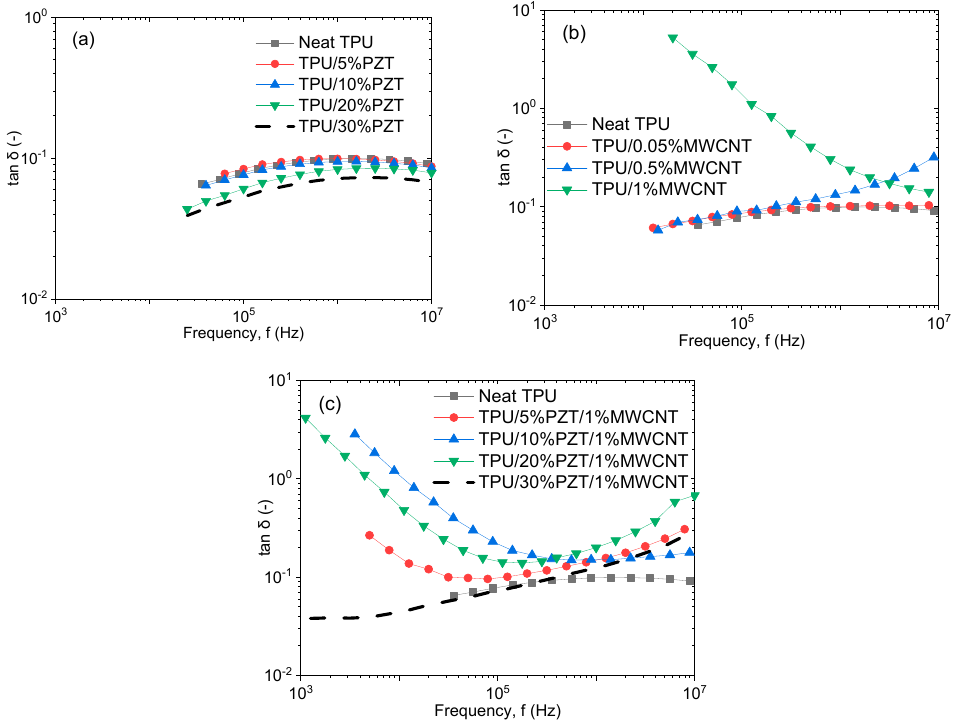
Figure 7. Broadband dielectric loss of ( a ) TPU/PZT, ( b ) TPU/MWCNT, and ( c ) TPU/PZT/1 vol% MWCNT composites.